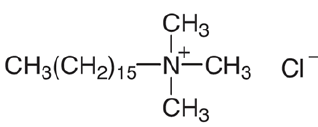
Figure 2. Hexadecyltrimethylammonium chloride (HDTMAC).